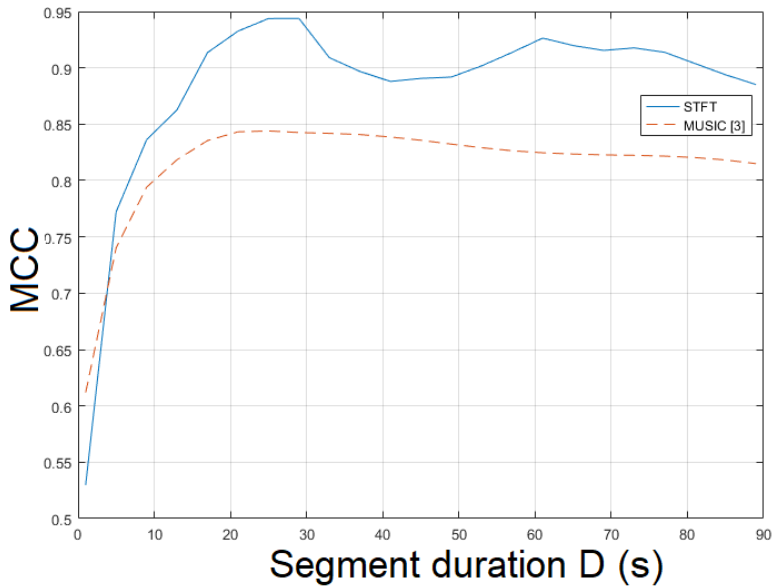
Figure 10. Maximum correlation coefficient of the proposed approach employing SLIC+STFT for various segment durations against the MUSIC [3]